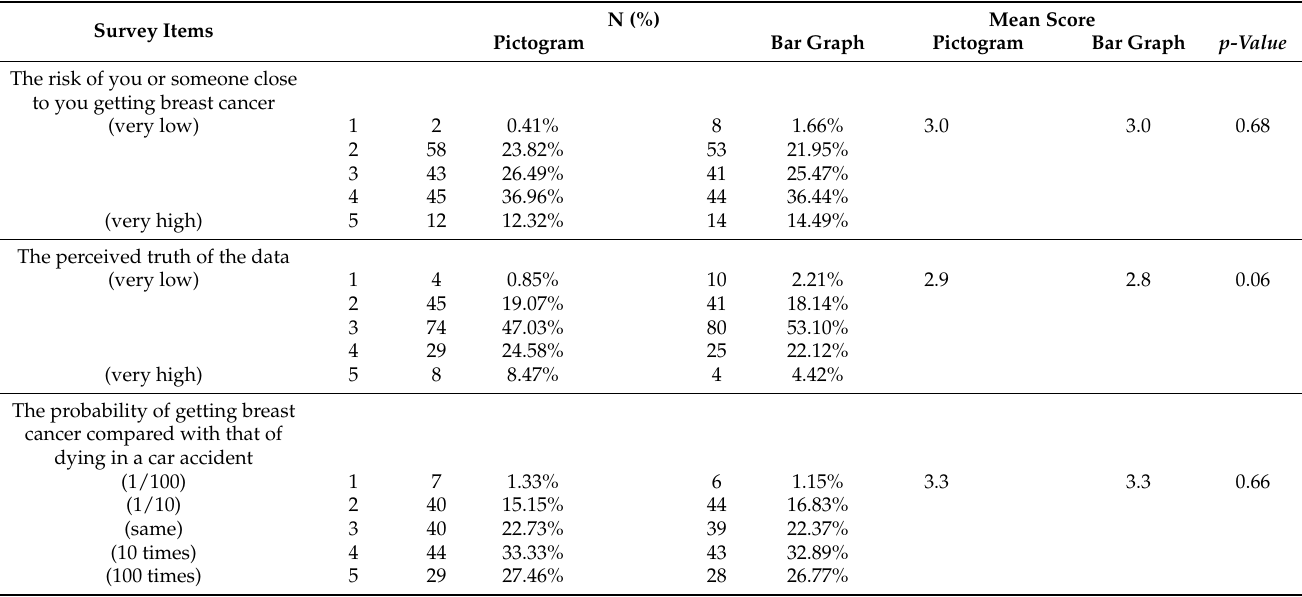
Table 2. Distribution of risk perception and data reliability by data presentation format.